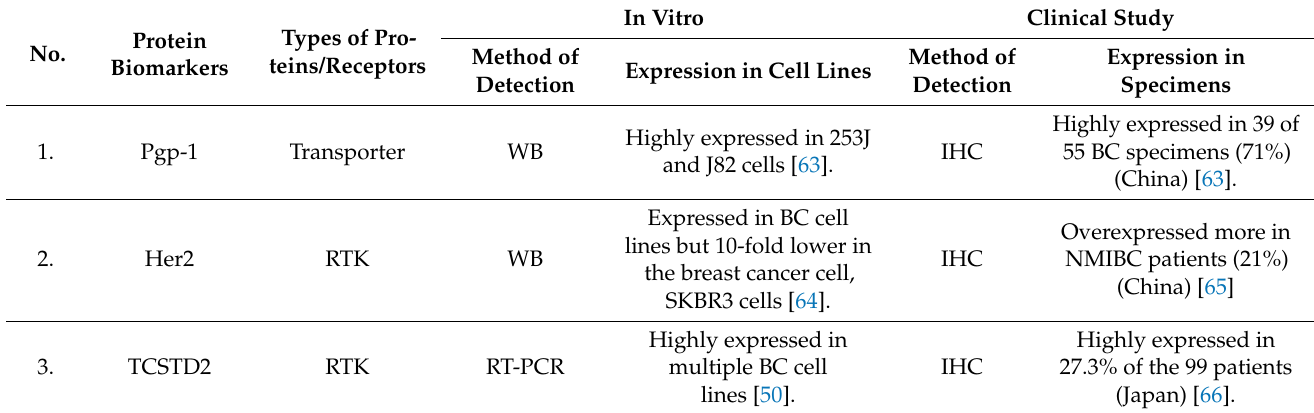
Table 2. Proposed membrane proteins for diagnosis and prognosis of bladder